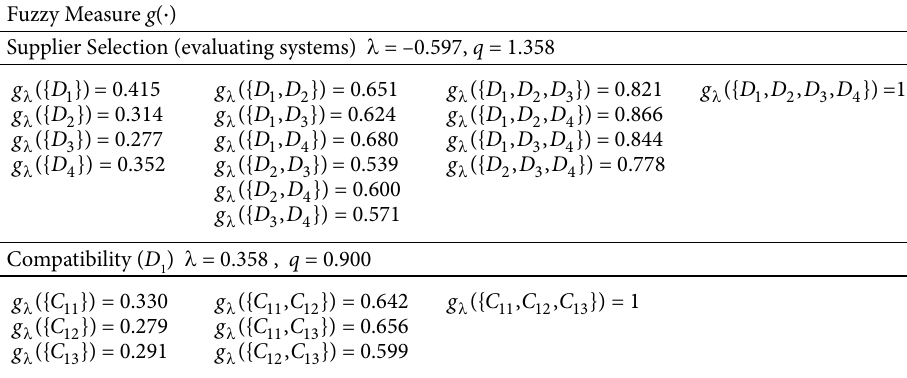
Table 5. Fuzzy measure g ( λ ) of each parameter and parameter combination Fuzzy Measure g ( ∙